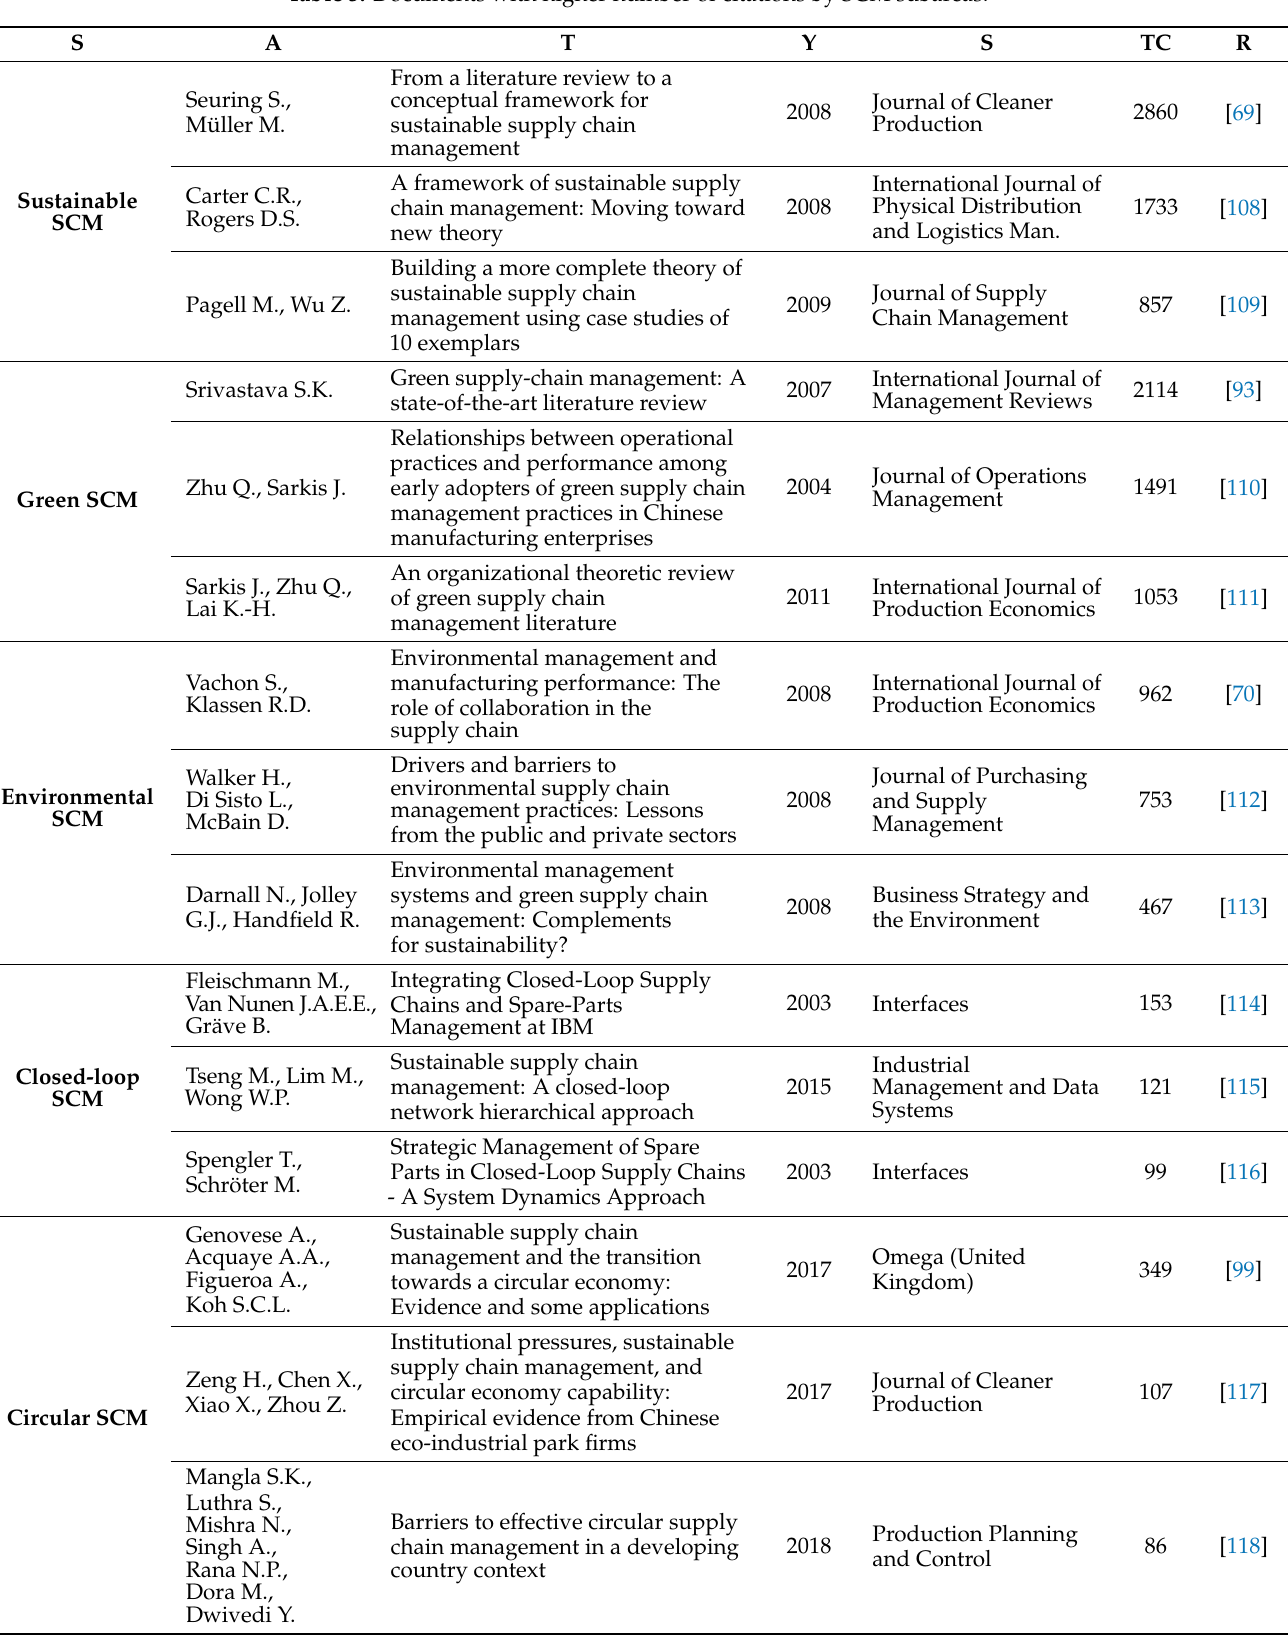
Table 3. Documents with higher number of citations by SCM subareas. S